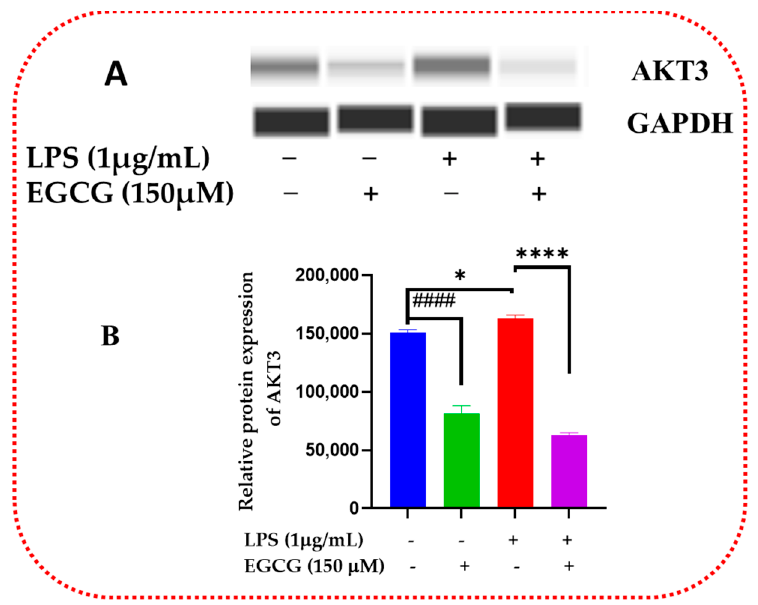
Figure 16. EGCG decreased the relative protein expression of Akt3. Western blot representative image of AKT3 shows that EGCG 150 µM coupled with LPS 1 µg/mL displayed in bands in ( A ) and graph in ( B ) reduced protein expression of the aforementioned analyte compared to LPS (red). EGCG 150 µM alone also decreased NF- κ B2 protein expression. GAPDH was used as a loading control. Values represent the mean ± SD, * p ≤ 0.05, and **** p ≤ 0.0001 vs. LPS, #### p <0.0001 vs. control.